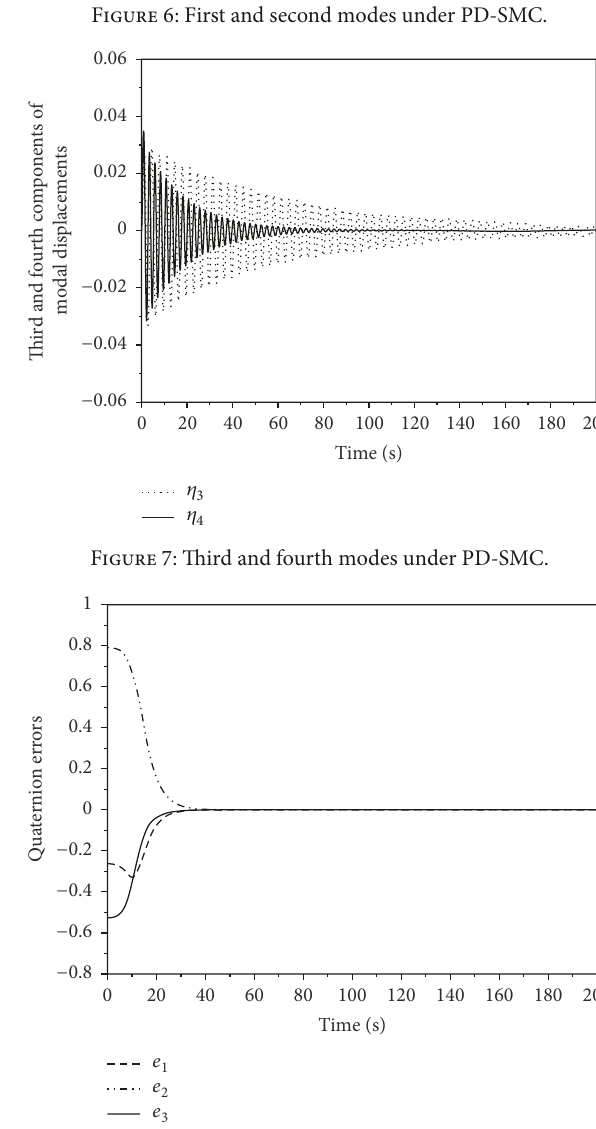
Figure 9: Scalar component of quaternion errors under controller (50).